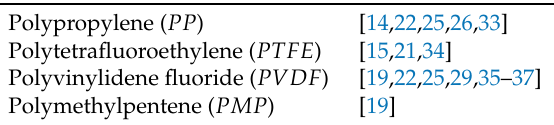
Table 2. Summary of common membrane materials used in hollow fiber membrane contactors (HFMCs) for CO 2 separation from flue gas.